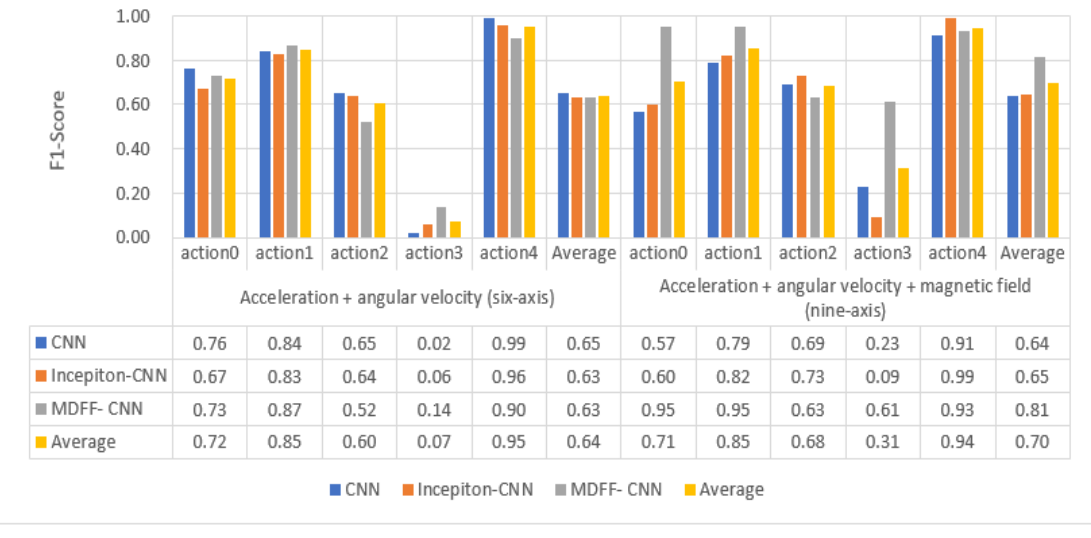
Figure 17. Recognition accuracy rate of convolutional neural network model on non-professional test set.